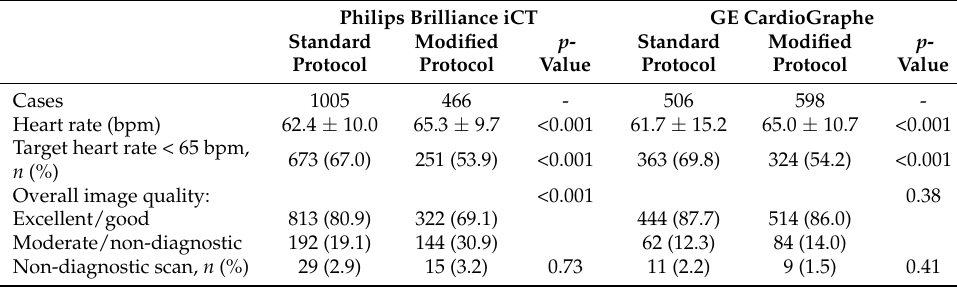
Table 3. Comparison of image quality using the different heart rate